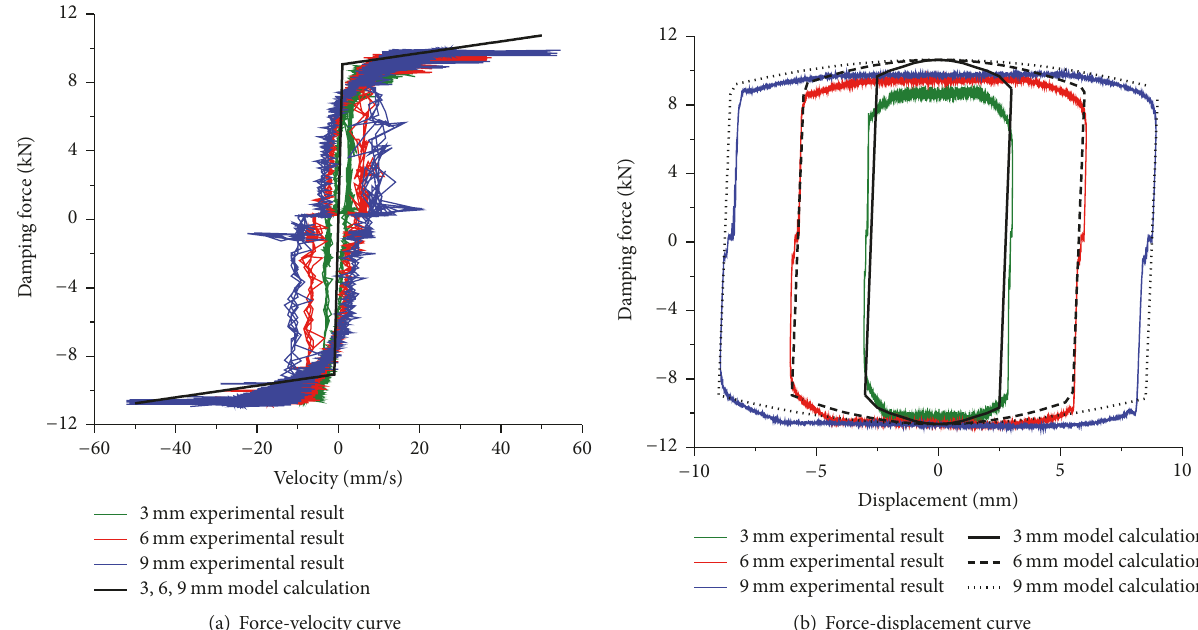
Figure 6: Comparison between model calculation and experimental results for different